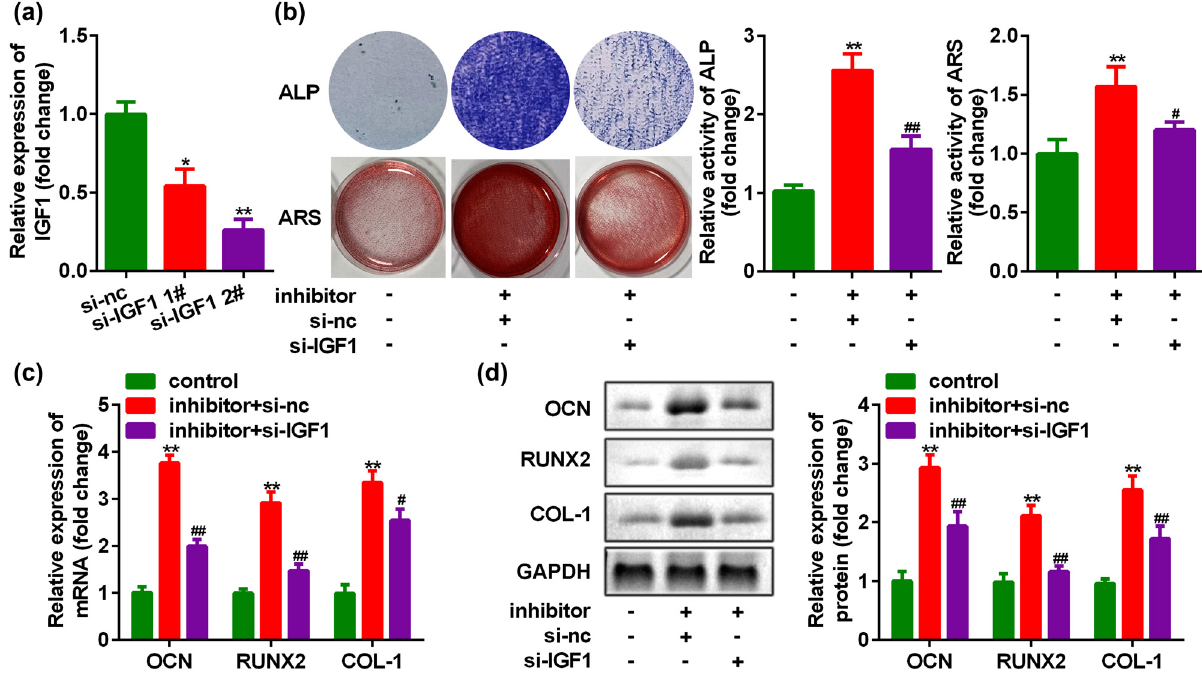
Figure 6: E ff ects of IGF1 on PDLSCs. ( a ) IGF1 expression levels were detected by qRT - PCR. ( b ) Images and quanti fi cation of ALP staining and ARS of PDLSCs transfected with miR - 142 - 5p inhibitor and si - IGF1. ( c ) qRT - PCR analysis for the expression of OCN, RUNX2, and COL - 1. ( d ) Western blotting analysis for the expression of OCN, RUNX2, and COL - 1. * p < 0.05, ** p < 0.01, vs si - nc, and control group. # p < 0.05, ## p < 0.01, vs inhibitor + si - nc